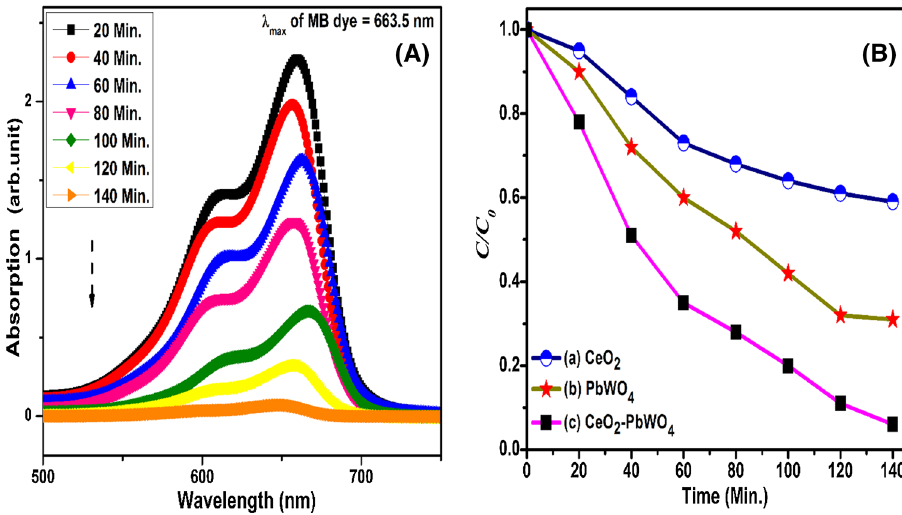
Fig. 8 a UV–Vis absorption spectra of MB dye solution using CeO 2 /PbWO 4 NCs under visible-light exposure b Pho- todegradation rate of prepared